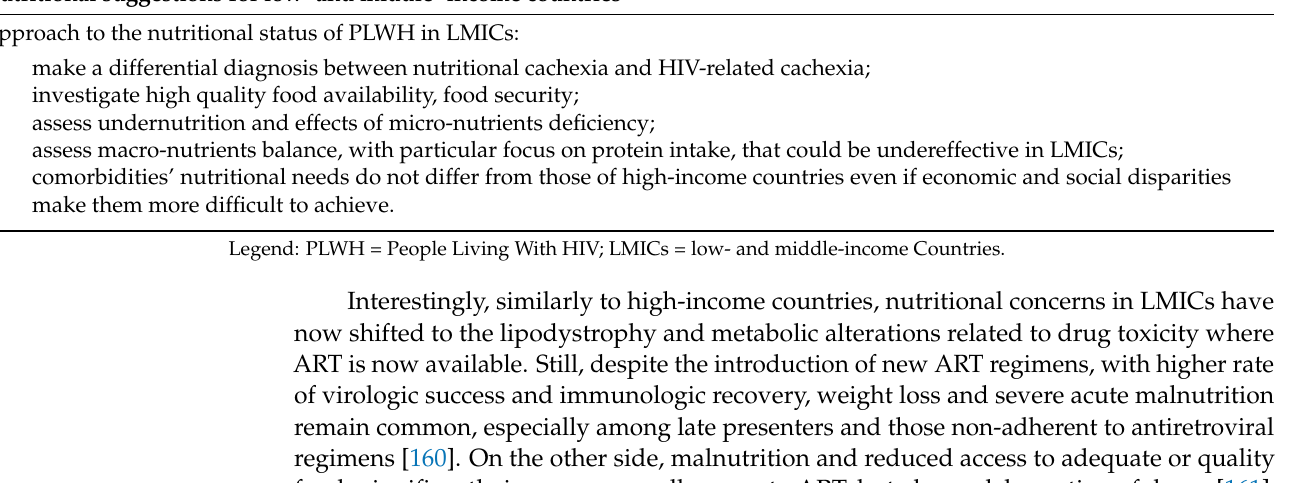
Table 5. Overview of diagnosis and nutritional management of PLWH in low- and middle-income countries. Nutritional suggestions for low- and middle- income countries Approach to the nutritional status of PLWH in